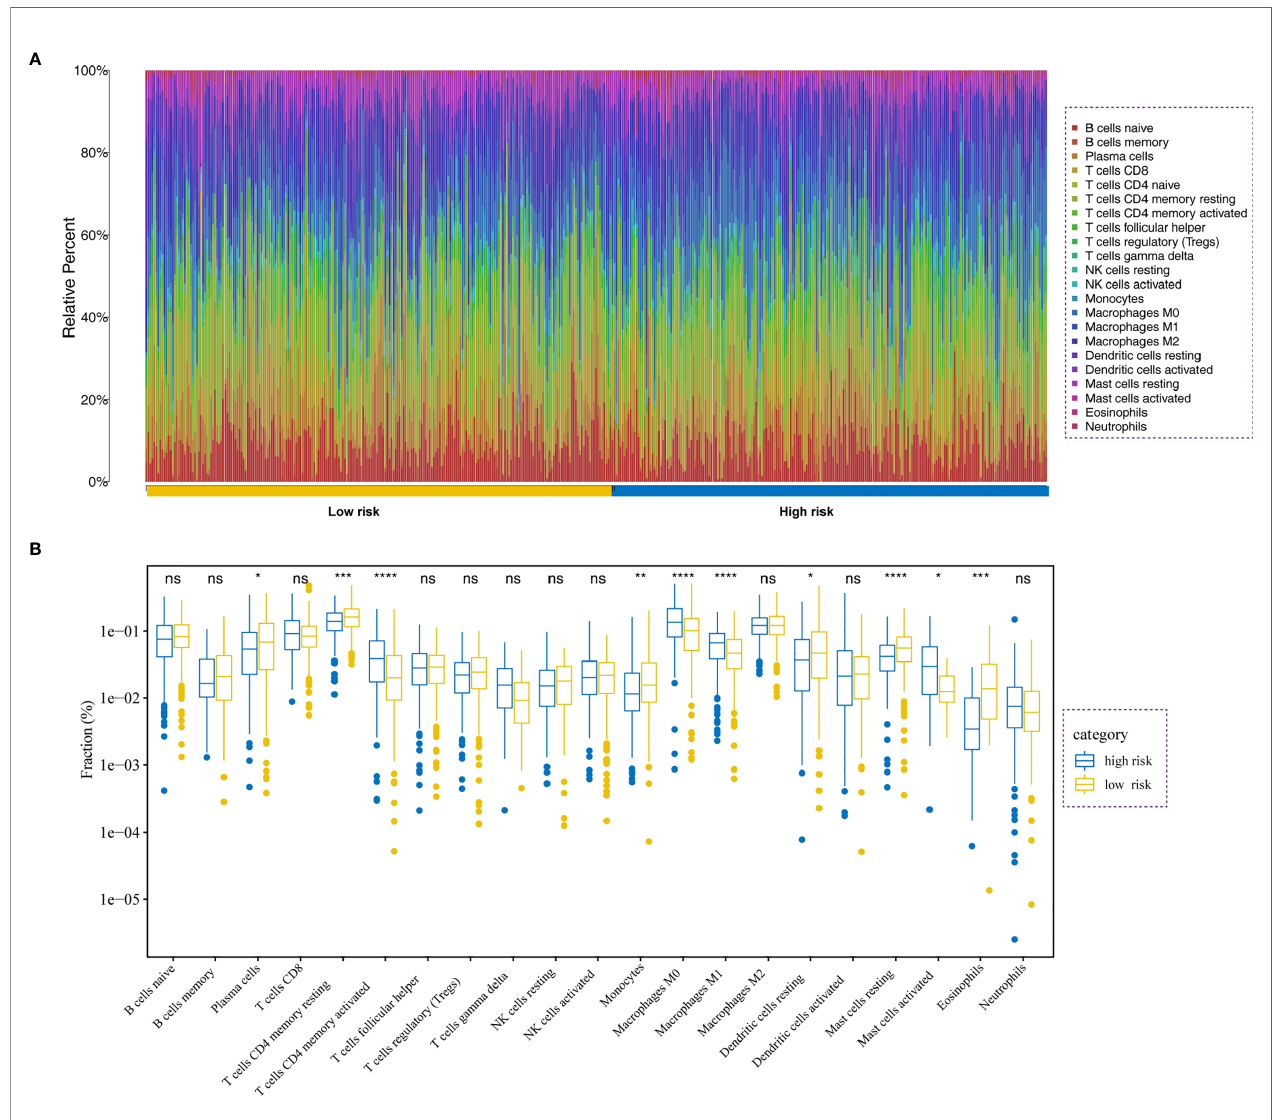
FIGURE 8 | Immune analysis. (A) Relative proportion of immune cell in fi ltration in high- and low-risk patients. (B) Differences in immune cell in fi ltration between low- and high-risk LADC patients *P<0.05, **P<0.01, ***P<0.001, ****P<0.0001, ns, no signi fi